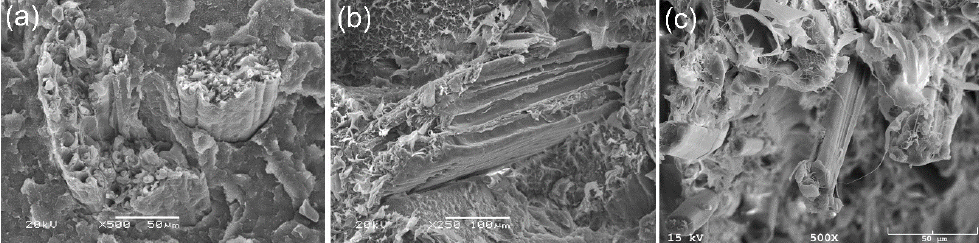
( c ) flax fiber. Figure 3. SEM images of bio-polyethylene composites with ( a ) coconut shell fiber, ( b ) wood flour, and